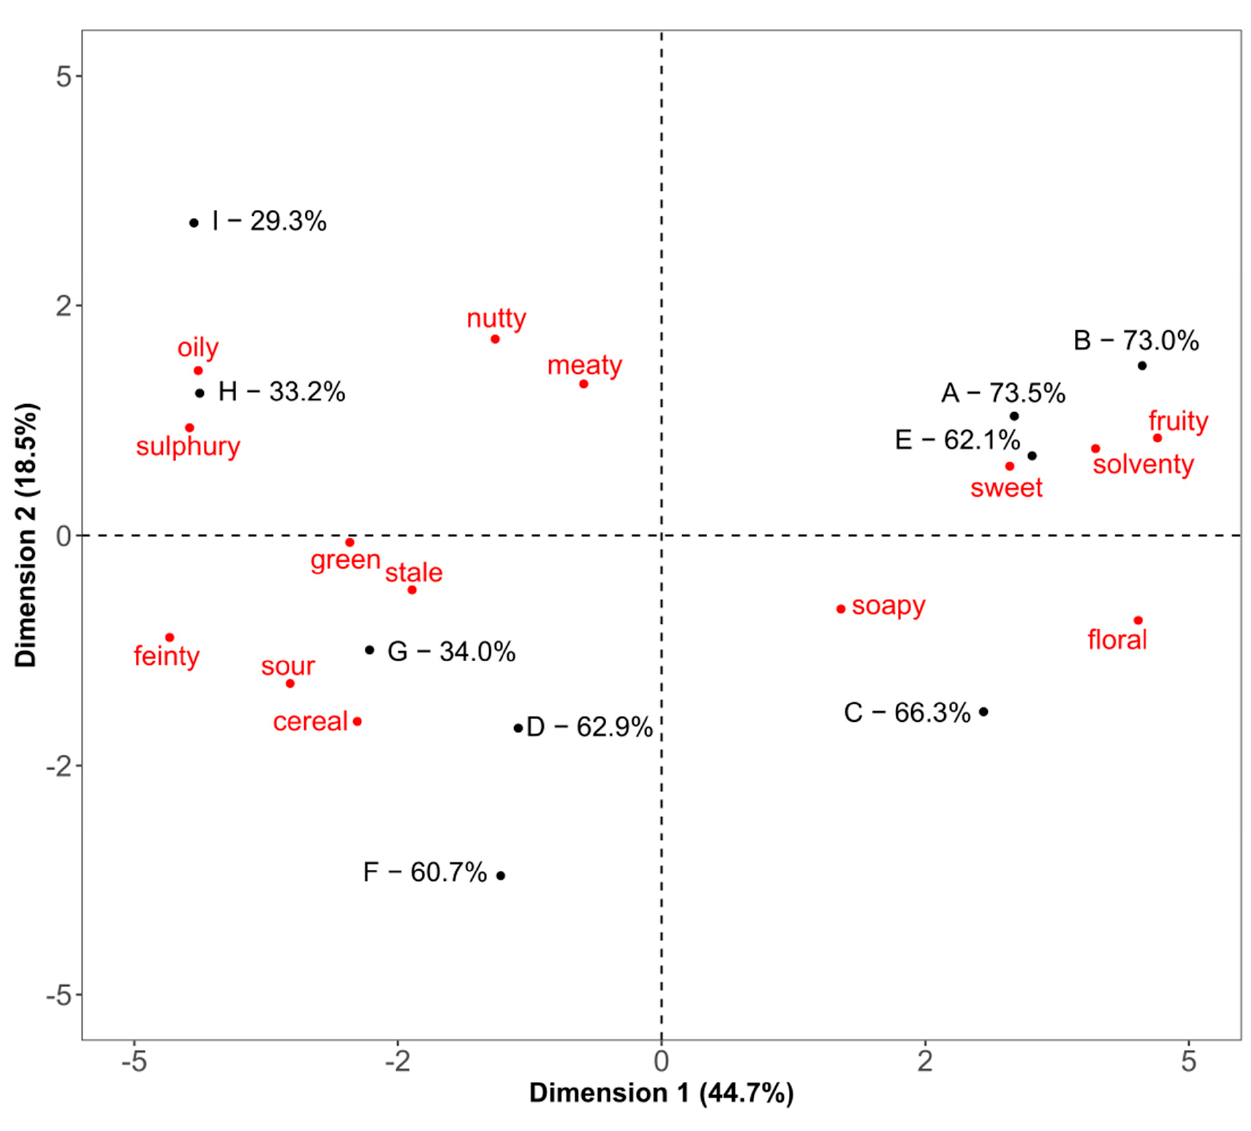
Figure 3. MFA biplot of the Napping data for nine new make spirits (percentages next to the sample codes indicate the ABV). Red descriptors depict supplementary flavour information.